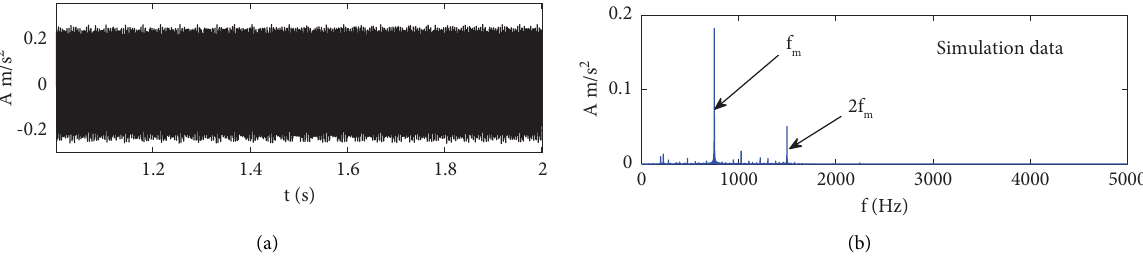
Figure 22: Te responses of the bearing node of the driven shaft: (a) the time domain; (b) the frequency